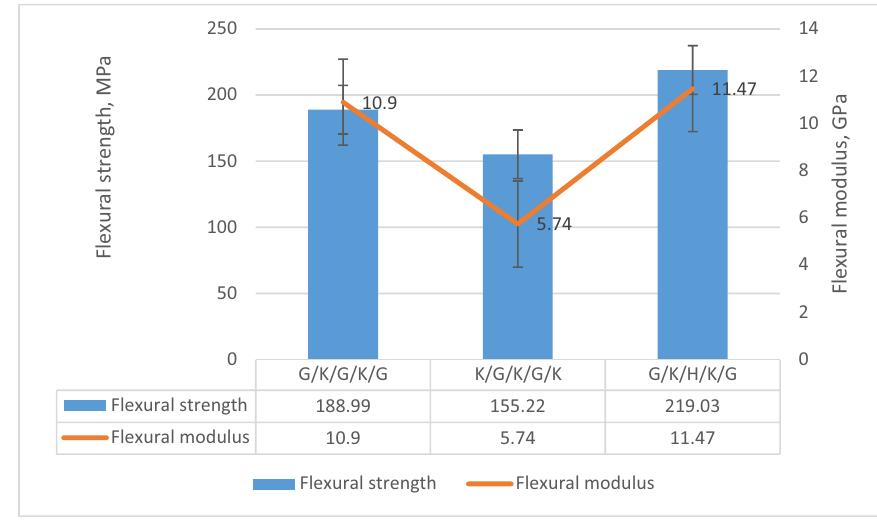
Figure 6: Flexural strength and modulus of the laminate